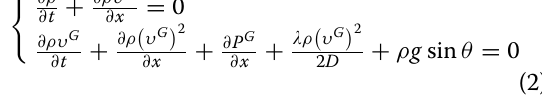
manifests as the response delay of the arrival of the mini- mum gas pressure and the available gas storage. thermal inertia is shown in Fig. 1a. When the input power fluctuates on the thermal sources, thermal inertia mainly manifests as: (1) the response delay of the arrival of the minimum indoor temperature; and (2) the comfort range within which temperature is allowed to change. There-